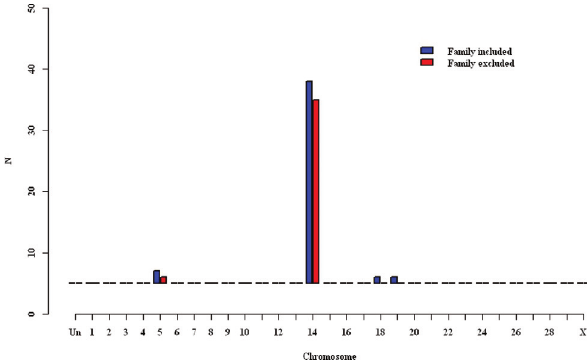
Figure 3 - Number of detected SNP loci associated with birth weight by chromosome from analyses with the genomic relationship matrix included withandwithoutthefixedeffectoffamily(“Un”representsSNPthatwere not assigned to any